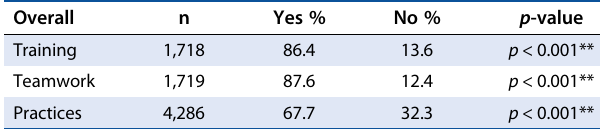
Table 5: Overall training, teamwork and practice Overall